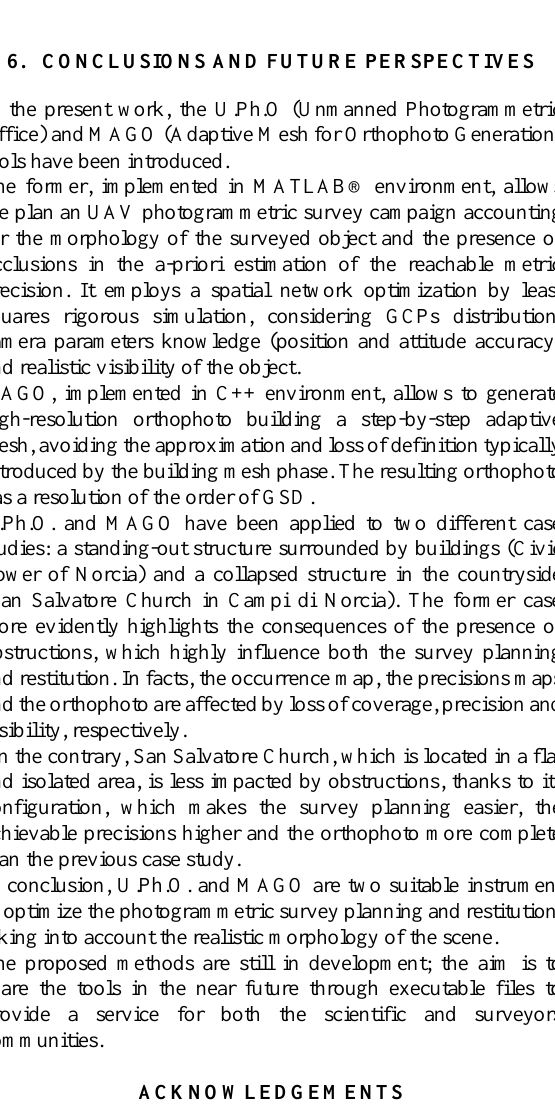
Figure 15. Orthophoto by